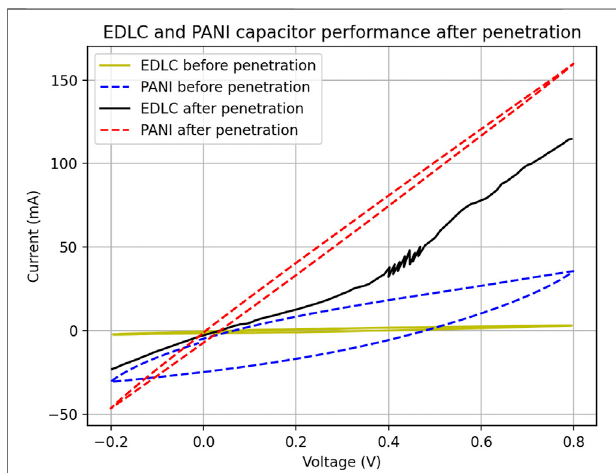
FIGURE 10 | Current vs. Voltage for supercapacitors before penetration and after